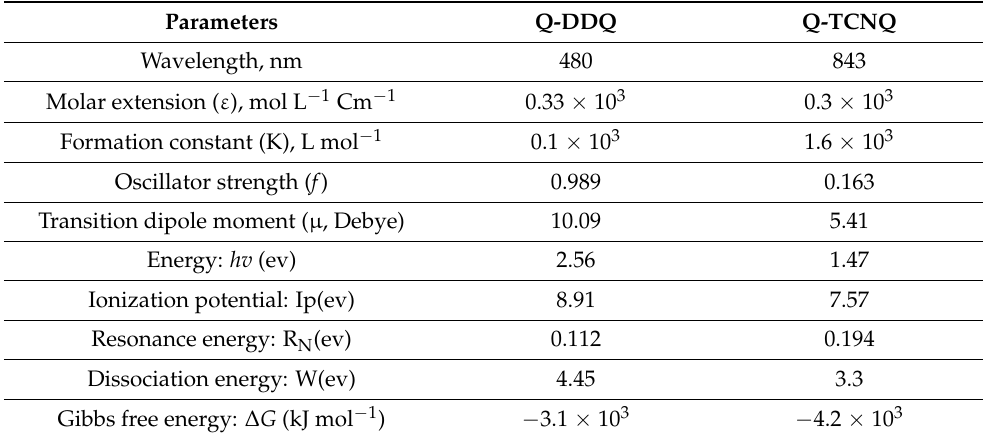
Table 2. Spectroscopic characteristics of quinine charge transfer